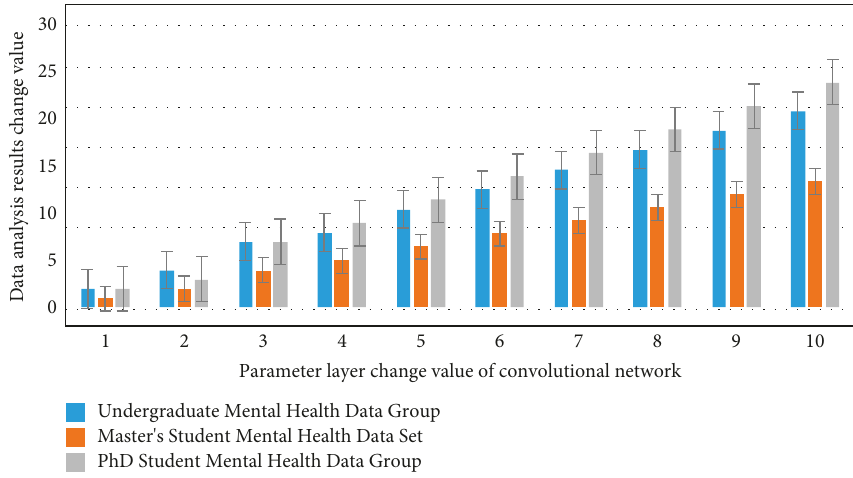
Figure 5: Variation trend of data redundancy percentage of convolutional neural network for the mental health data of students in different colleges and universities (8 data balance